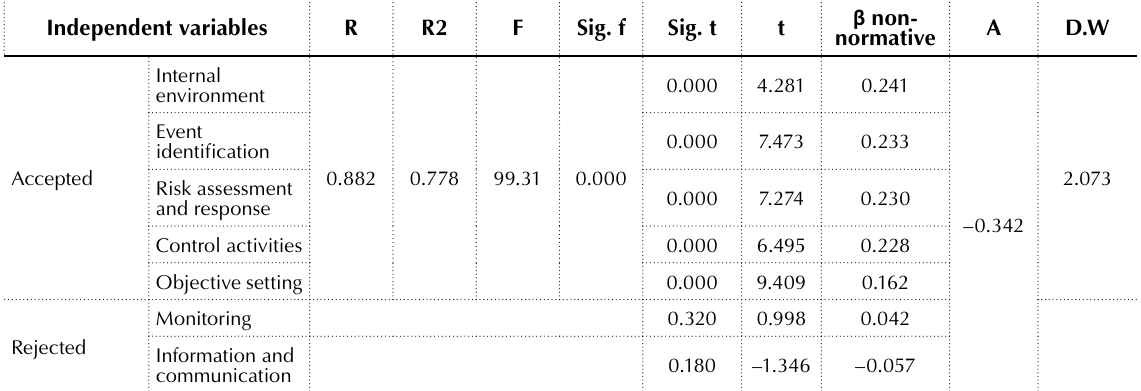
Table 1. Results of a multiple linear regression analysis to test the main hypothesis ( H